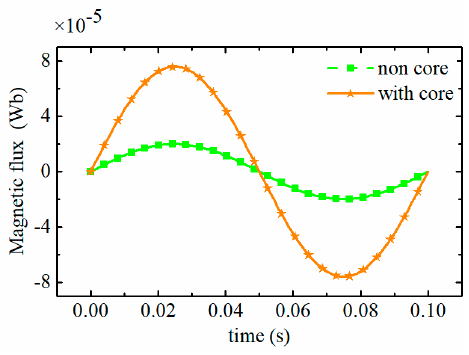
Figure 5. Magnetic flux of the inductive coil.